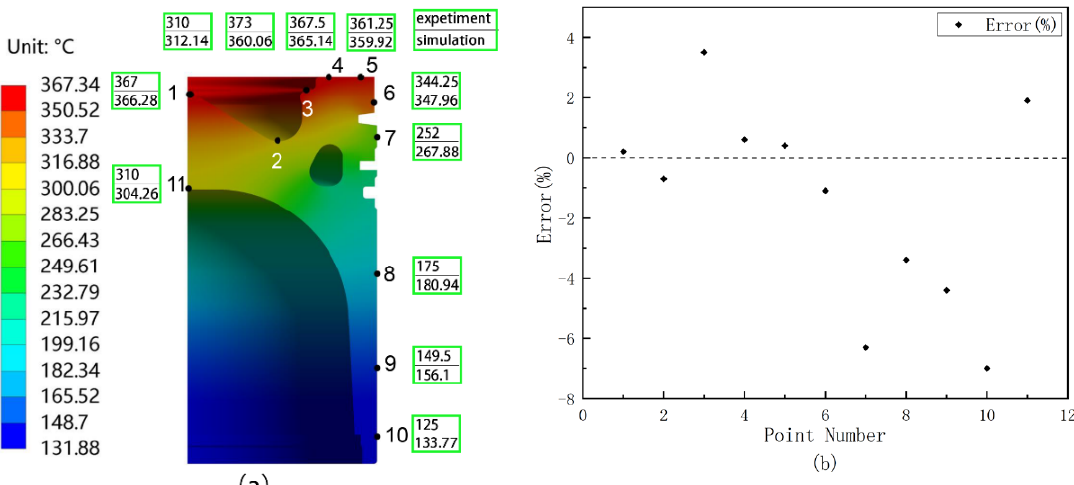
Figure 6. ( a ) Temperature distribution of the uncoated piston ( b ) Errors of simulation and experimental values.